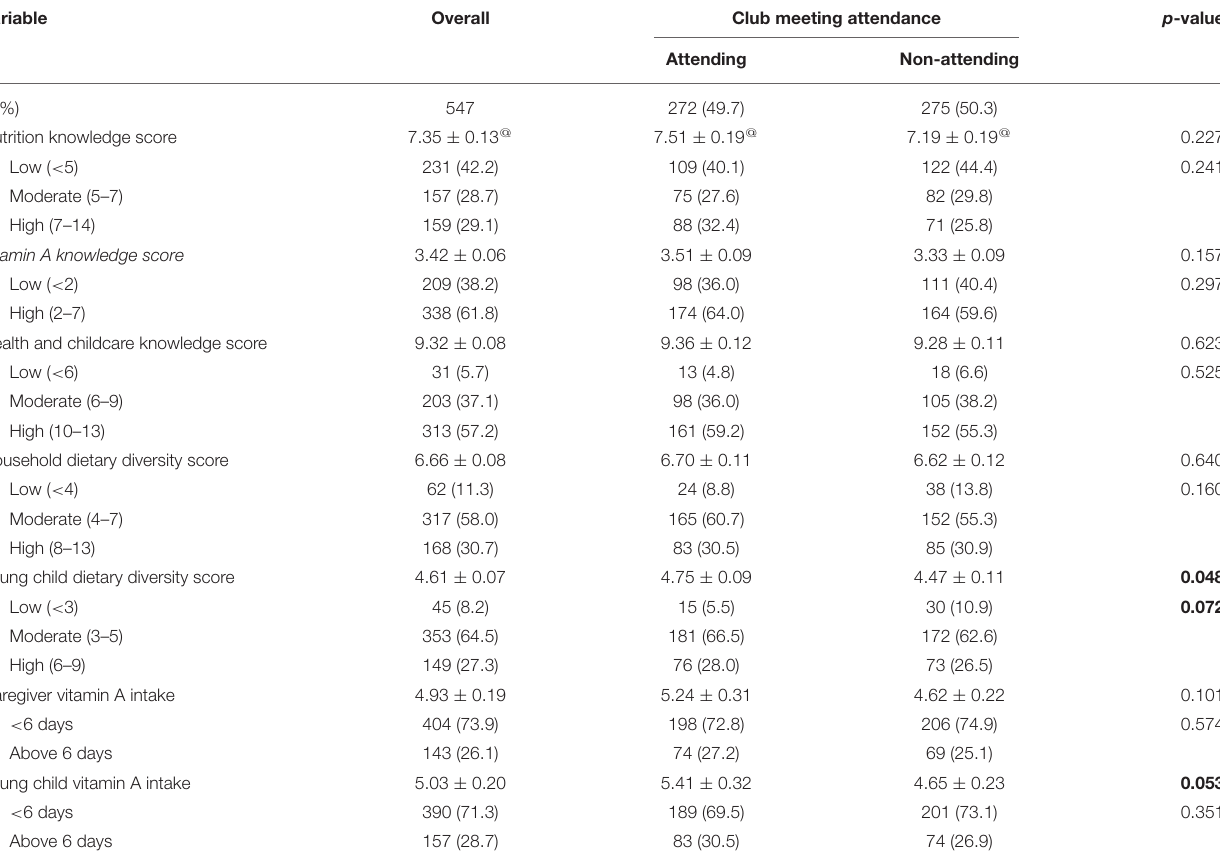
TABLE 2 | Knowledge and practices of primary caregivers of children under 5 years, overall and by nutrition club meeting attendance.